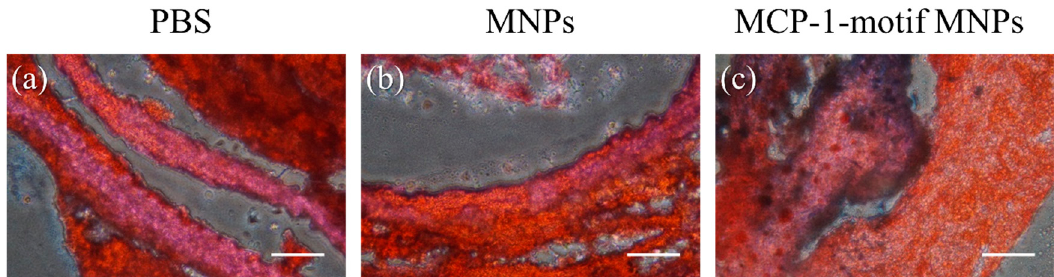
Figure 10. Prussian Blue and Oil Red O staining of the aorta of ApoE KO mice with injection of ( a ) PBS, ( b )MNPs, and ( c ) MCP-1-motif MNPs (scale bar = 50 μ m).